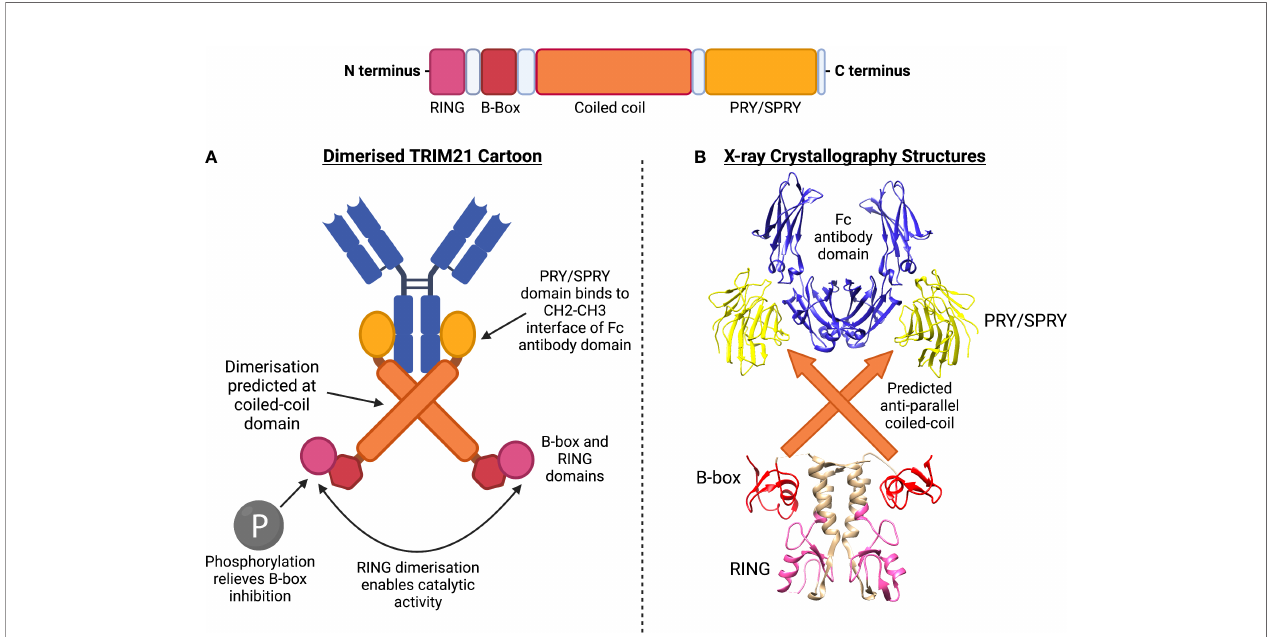
FIGURE 1 | TRIM21 structure includes RING, B-box, coiled-coil and PRY/SPRY domains. (A) Dimerised TRIM21 cartoon shows binding of PRY/SPRY domain at constant region (Fc) of antibody. Dimerisation at the coiled-coil is predicted according to homology to other TRIM family members. Phosphorylation of the LxxIS motif of the RING domain relieves B-box inhibition, allowing RING dimerisation for catalytic activity. (B) X-ray crystallography structures have been obtained for the (1) PRY/ SPRY domain, identi fi ed in complex with the Fc antibody domain (PDB:2IWG) (25). (2) The B-box and RING domains have been crystallised in a dimer con fi rmation (PDB:5OLM) (26). The central predicted coiled-coil structure has not been formally identi fi